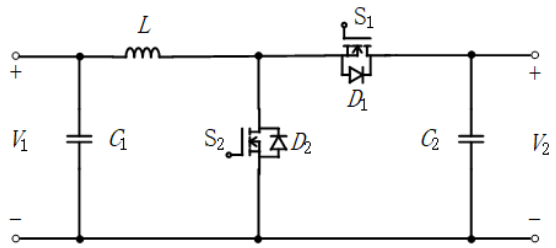
Figure 3. Non-isolated bidirectional DC-DC converters.